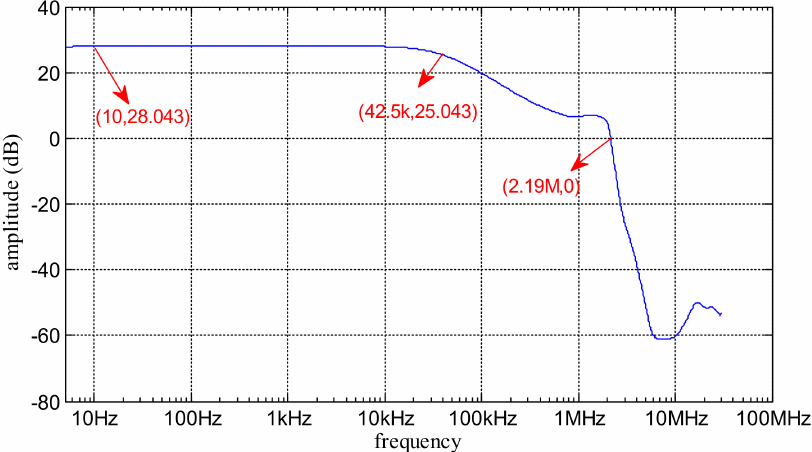
Figure 15. Measured frequency–amplitude characteristic for the power amplifier using high-voltage operational